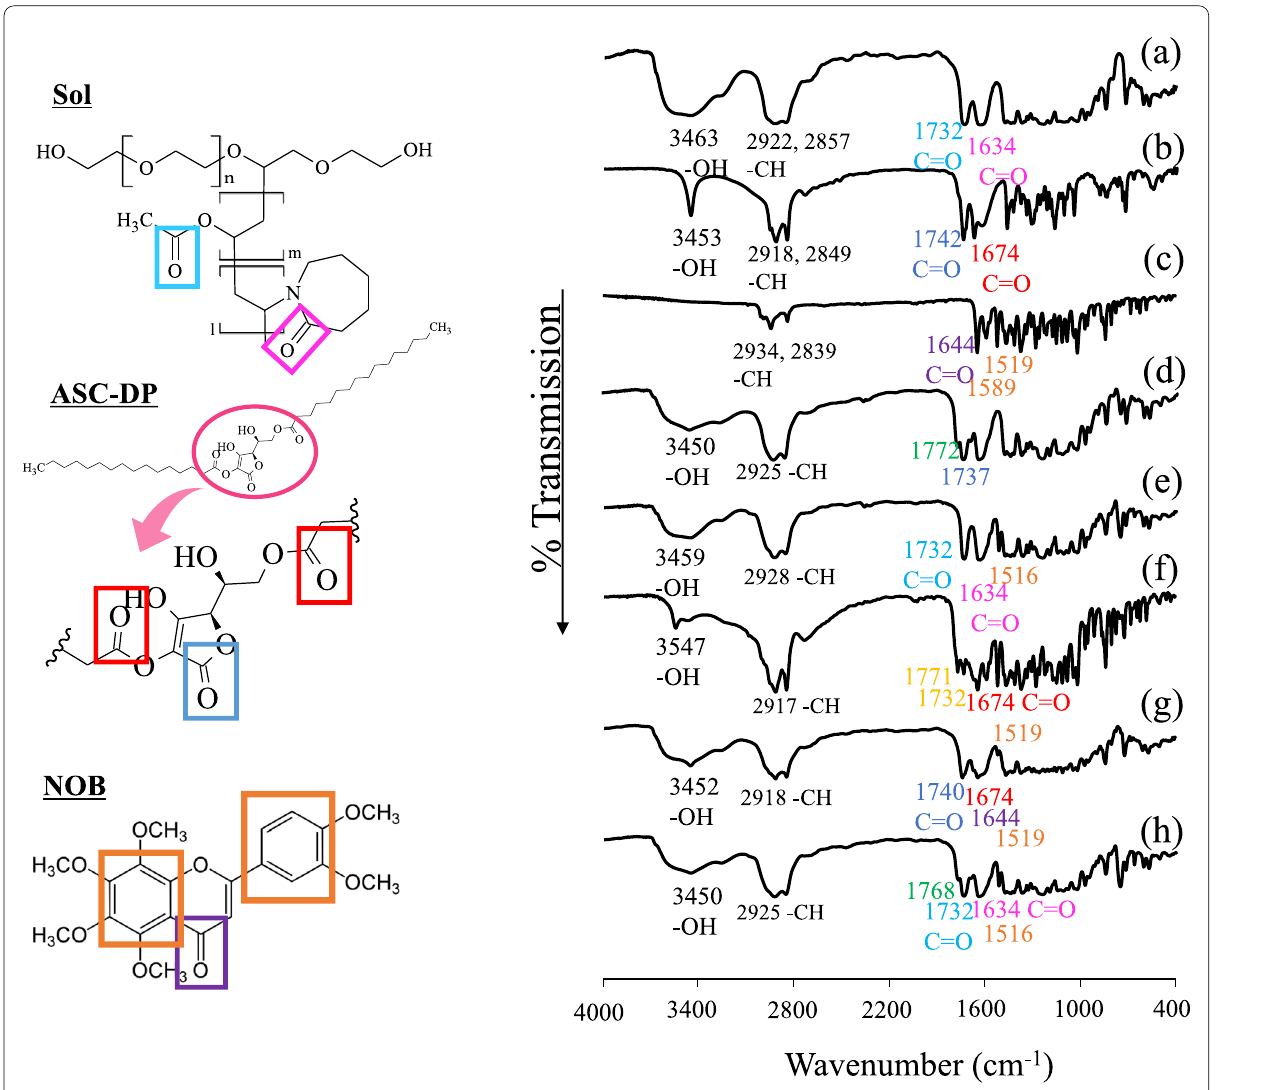
Fig. 8 FT-IR absorption spectra of Sol/ASC-DP/NOB systems. a Sol, b ASC-DP, c NOB, d EVP (Sol/ASC-DP (ASC-DP/NOB 1/1), g PM (Sol/ASC-DP/NOB =